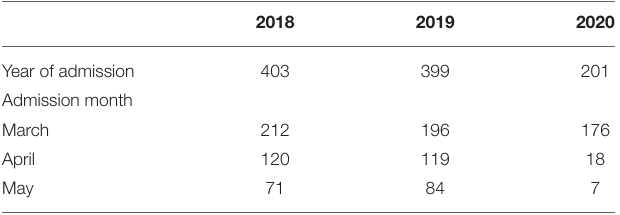
TABLE 2 | Number of hospitalization per year and per month.